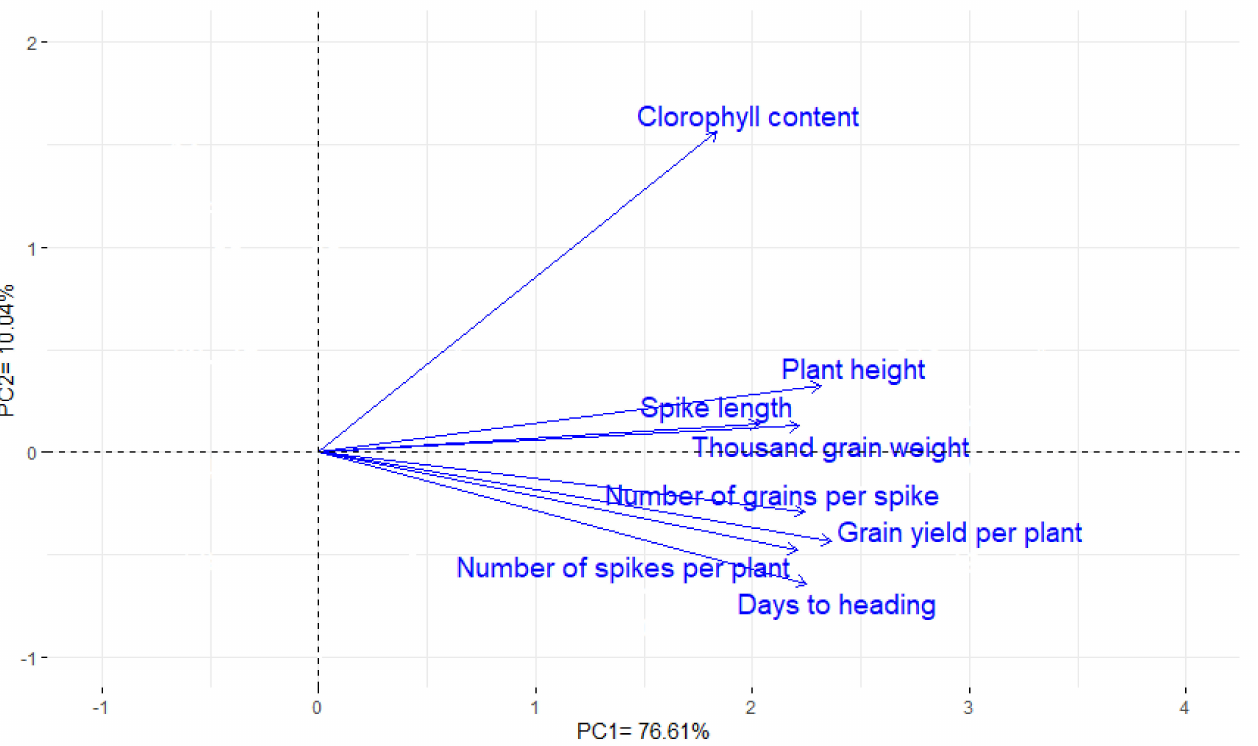
Figure 10. Biplot of principal component analysis displaying the relationship among the studied